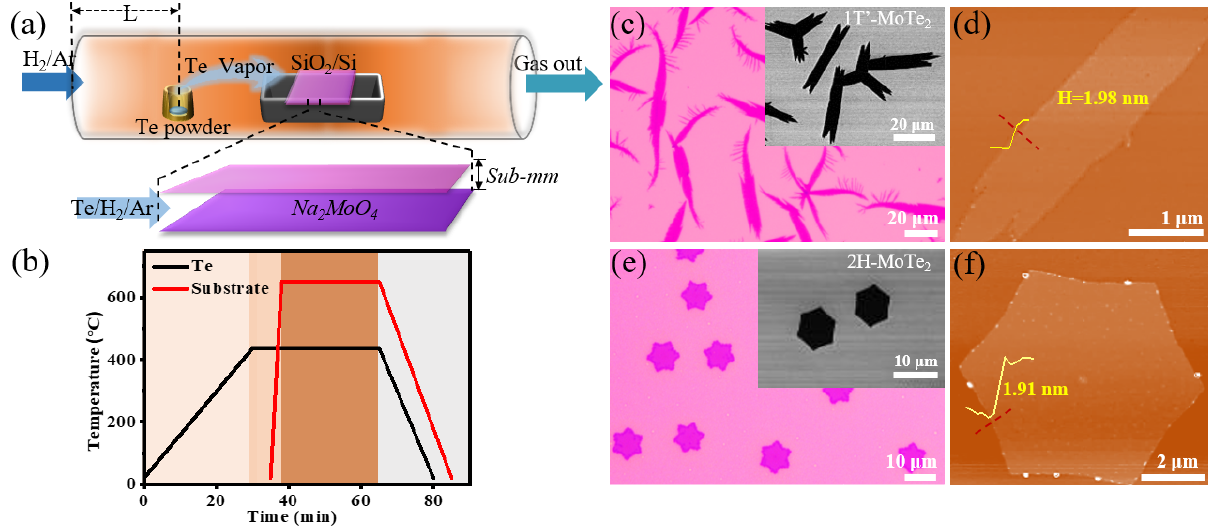
Figure 1. ( a ) Graphical representation of the space-confined CVD setup for the growth of atomically thin 2H-MoTe 2 and 1T (cid:48) -MoTe 2 ; the upper one of the face-to-face substrates is bare while the bottom one is coated by Na 2 MoO 4 solution. ( b ) Temperature profile for the Te powder (the black curve) and the face-to-face substrates (the red curve). ( c , d ) Optical microscopy image and atomic force microscopy (AFM) image of 1T (cid:48) -MoTe 2 grains grown on the top SiO 2 /Si substrate, respectively. The inset in ( c ) is the corresponding scanning electron micrograph (SEM) image. ( e , f ) Optical microscopy image and AFM image of 2H-MoTe 2 grains grown on the upper SiO 2 /Si substrate, respectively. The inset of ( e ) is the corresponding SEM image.